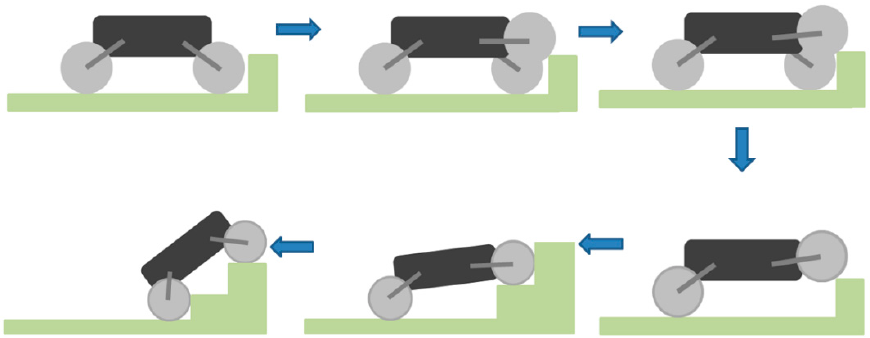
Figure 6. Diagram of obstacle crossing process of